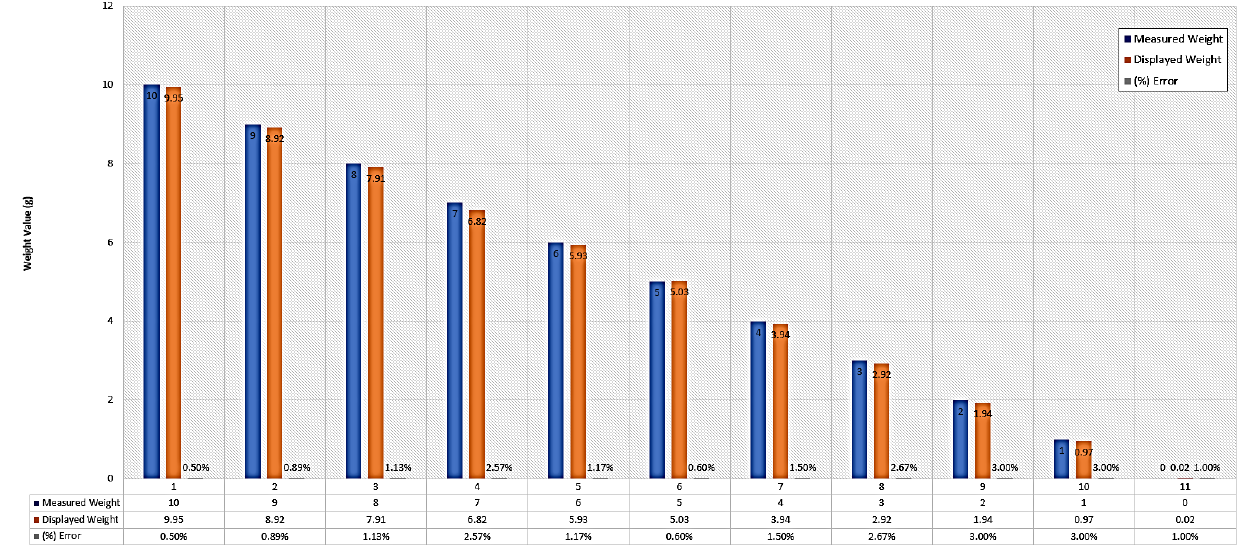
Figure 11. Results from the trial on VLC tele-weight device between 0 and 10 kg weight. A few repeated trials are made for the weight in the range of 0 to 10 kg (by incre-